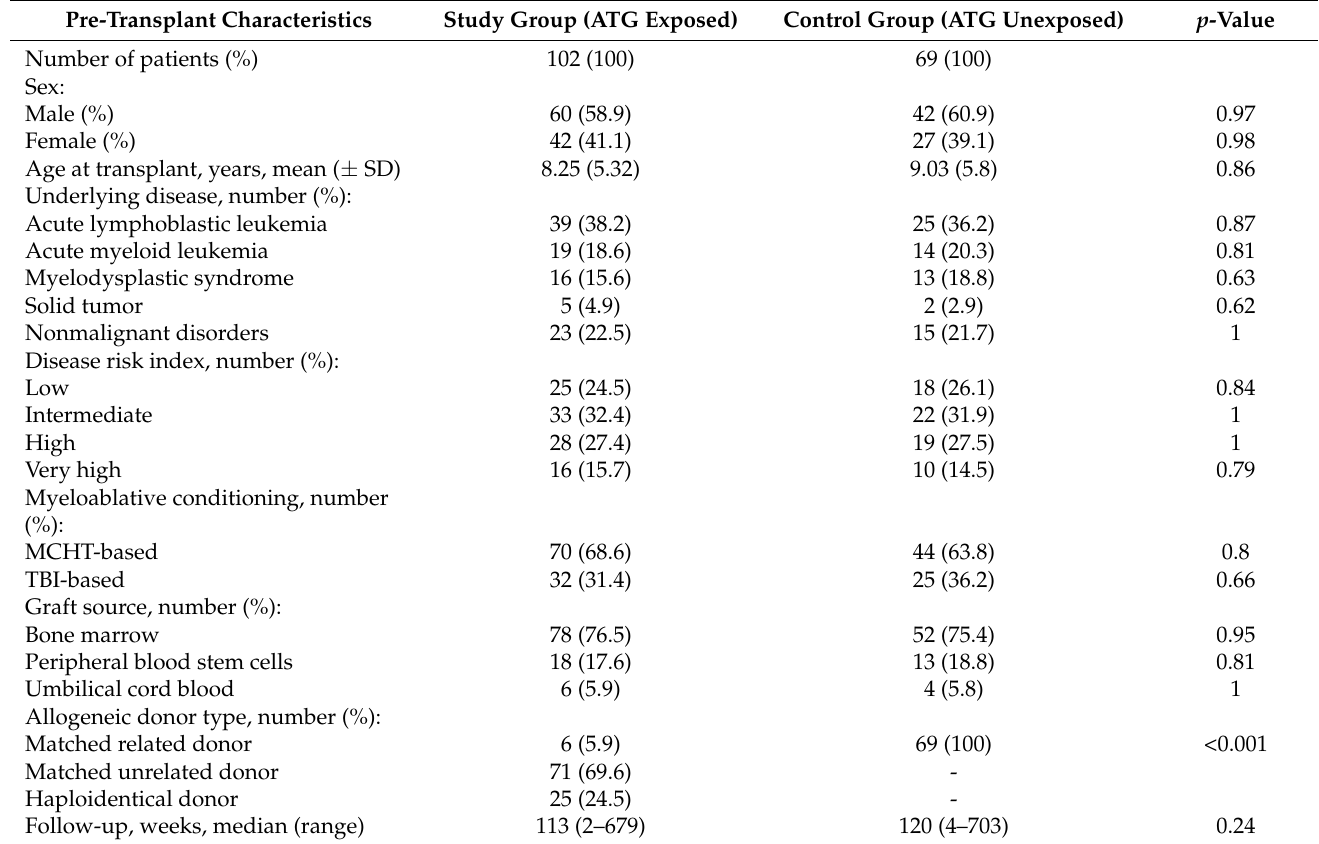
Table 1. Patient demographics and transplant characteristics of patients in low ATG/lymphocyte ratio group and high ATG/lymphocyte ratio